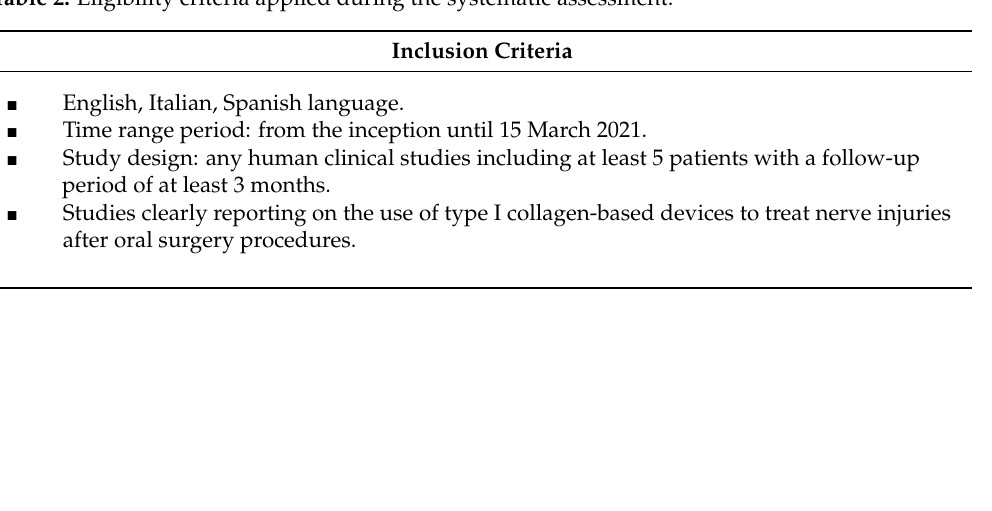
Table 2. Eligibility criteria applied during the systematic